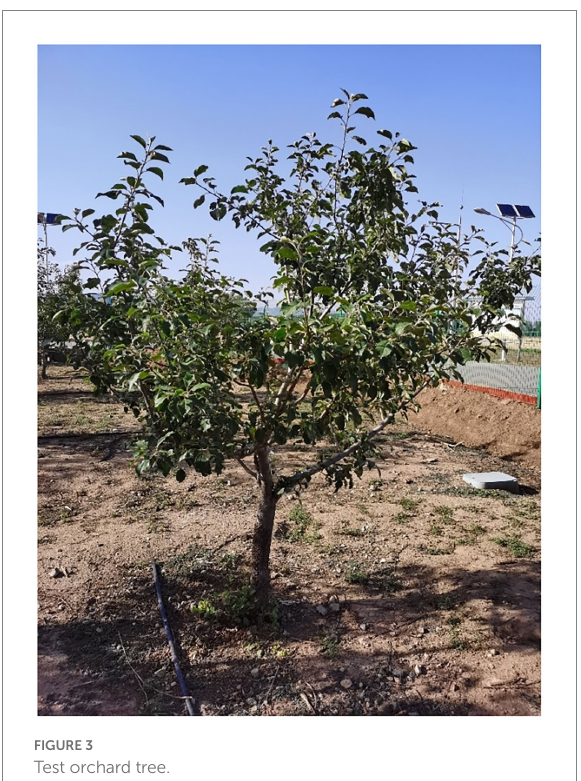
FIGURE 3 Test orchard